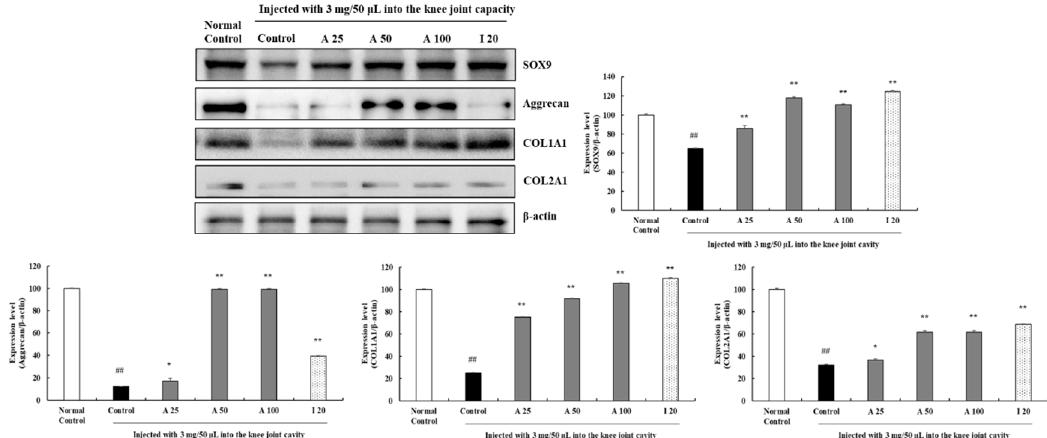
Figure 10. AyuFlex ® treatment attenuated the degradation of collagen synthesis-involved proteins in arthrodial cartilage. The expression of SOX9 (65 kDa), aggrecan (110 kDa), COL1A1 (220 kDa), and COL2A1 (190 kDa) was determined by western blotting. Protein bands were quantified utilizing ImageJ. As the control for normalization, β -actin was utilized. The results are expressed as the mean ± SEM of independent experiments ( n = 3 / group). A, AyuFlex ® ; I, Ibuprofen. * p < 0.05 and ** p < 0.01, in comparison with the MIA-induced control group; ## p < 0.01, in comparison with the non-MIA induced control